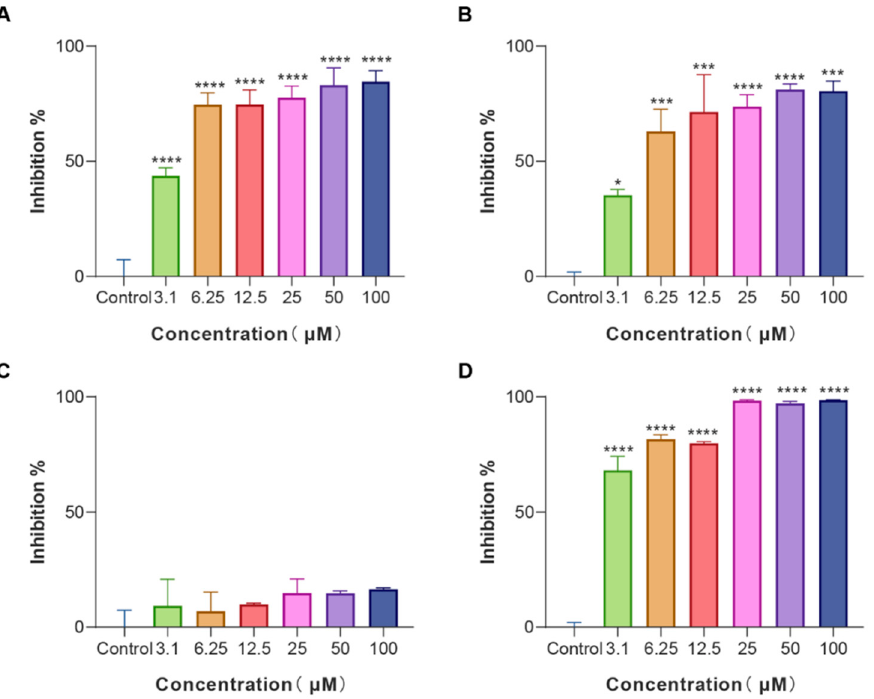
Figure 3. Biofilm inhibition activity of LS-AMPs on E. coli biofilm formation ( A ), LS-AMP-E1; ( B ), LS-AMP-F1; ( C ), LS-AMP-G1; ( D ), Lycosin-I. Data represent means ± SE of 3 individual experi- ments. * p < 0.05, *** p < 0.001 and **** p < 0.0001.